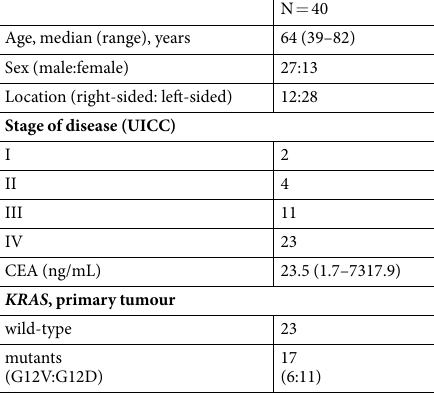
Table 2. Patients’ characteristics. CEA, carcinoembryonic